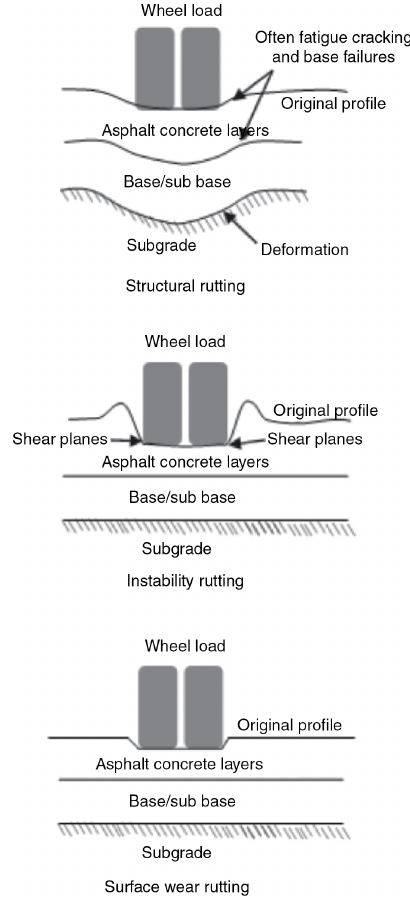
Figure 3: Types of asphalt pavement rutting